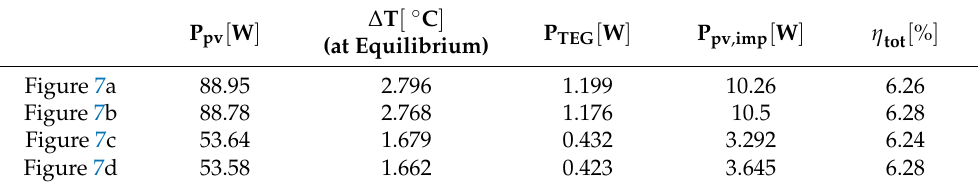
Table 4. Results according to Figure